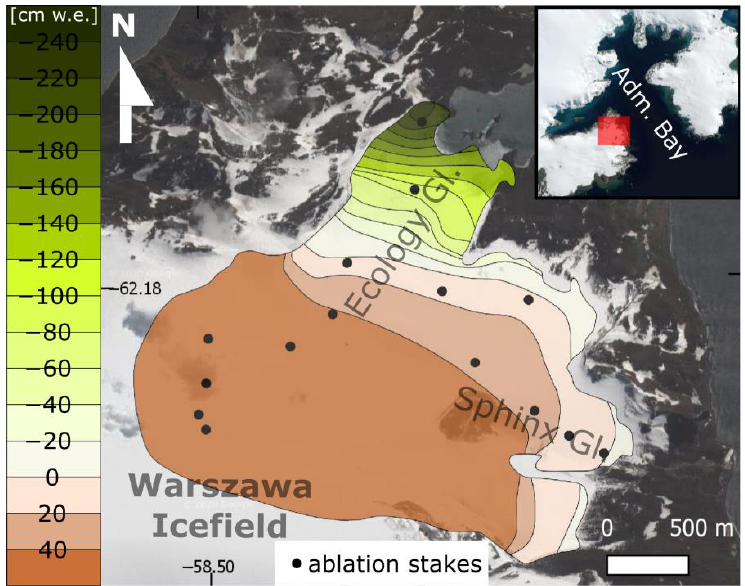
Figure 9. Mass balance map of the Ecology and Sphinx Glacier systems from 2012 – 2013. Adapted with permission from Sobota et al. [35], published by Cambridge University Press, 2015.